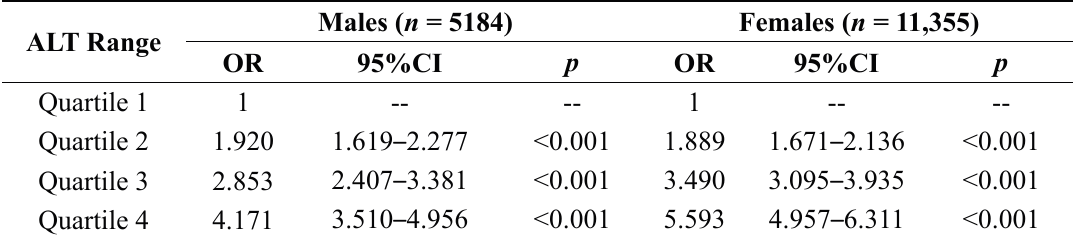
Table 4. Multiple logistic regression for metabolic